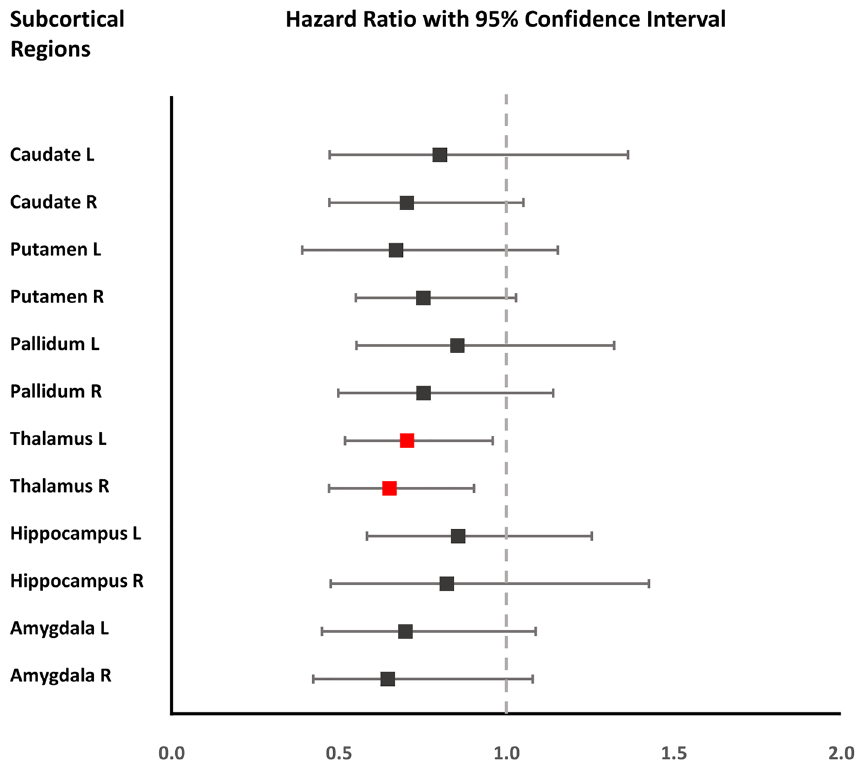
Figure 2. Association between the subcortical structures and onset of LID. A forest plot showing the hazard ratio and 95% confidence intervals of the early onset of LID according to the subcortical structures. The results are based on a Cox proportional hazard model, after adjusting for age, sex, disease duration, levodopa- equivalent dose increments per year, dopamine transporter availability in the posterior putamen, and intracranial volume. The red square indicates the subcortical structures that are significantly associated with the onset of